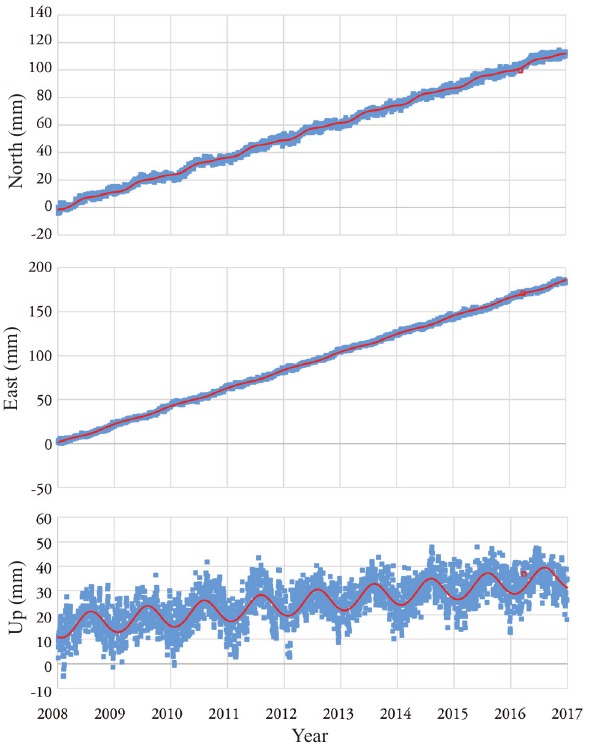
Fig. 4. The North, East and Up coordinate (blue squares) time series of the CORS station TOIL (Fig. 1) from 2008 to 2016. The red line represents the linear trend plus annual and semi- annual periodic